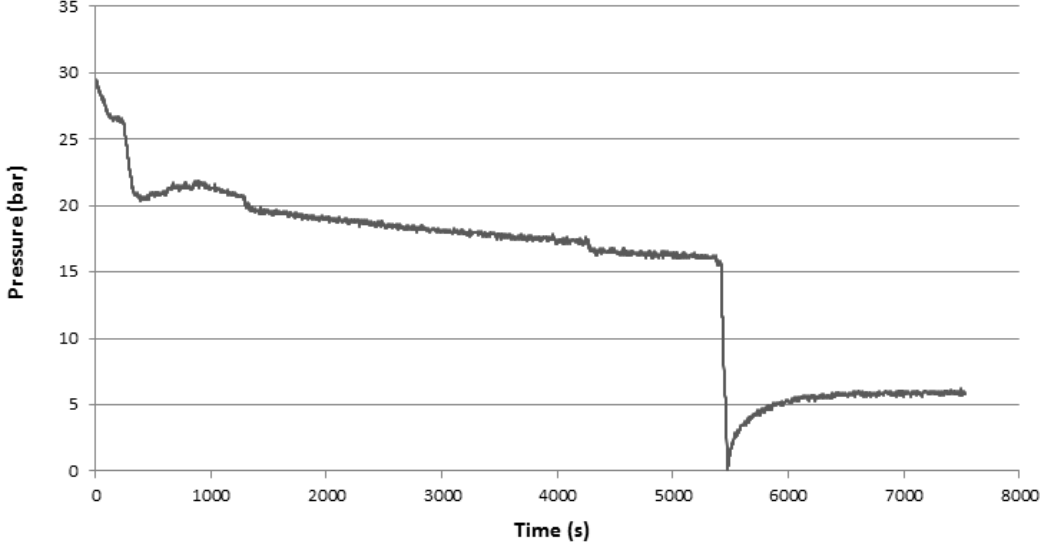
Figure 10. Pressure trend during the CO 2 replacement test.